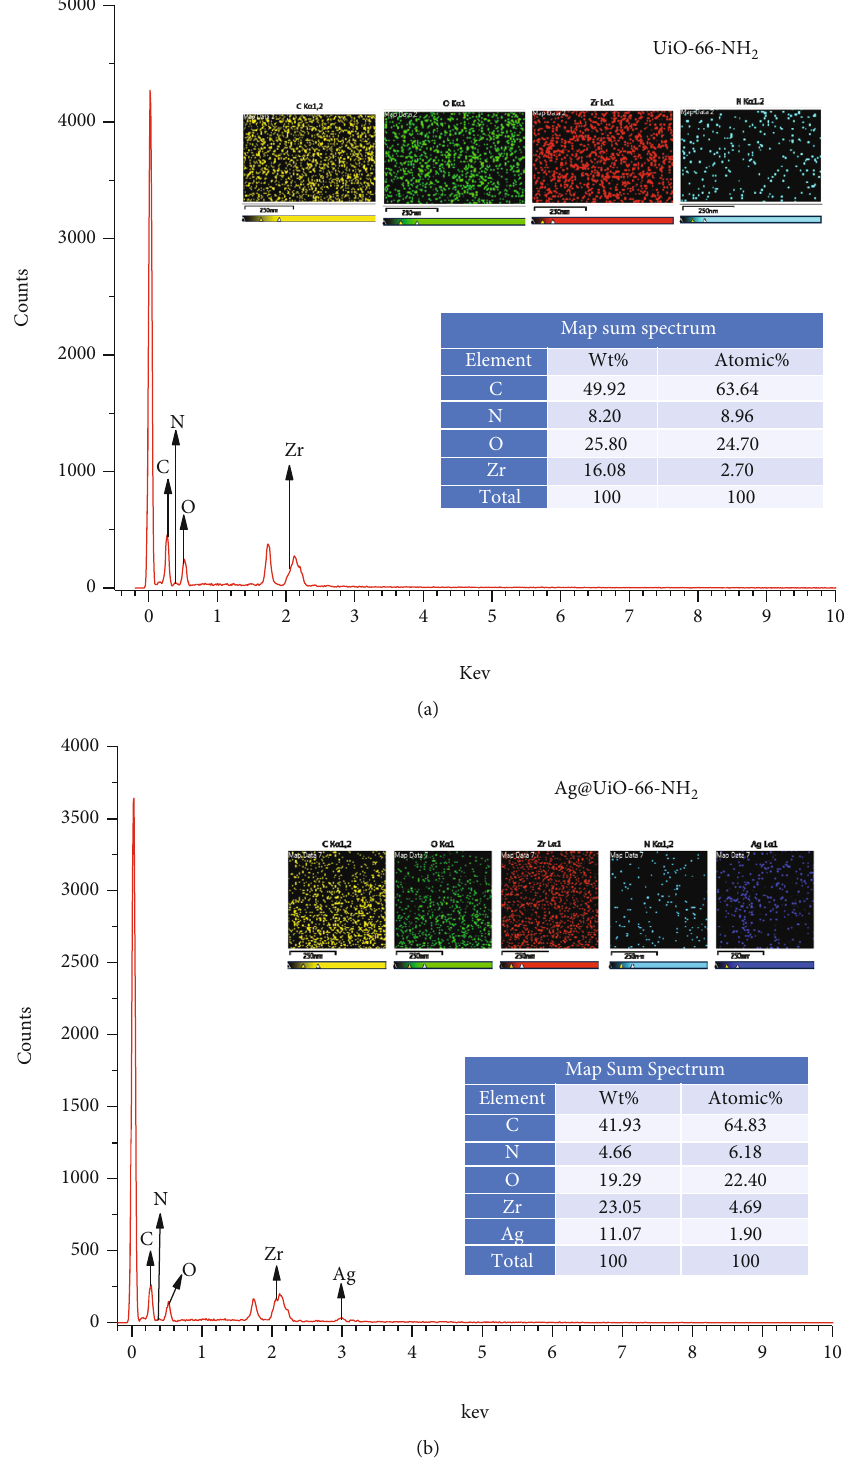
Figure 4: EDS mapping of (a) UiO-66-NH